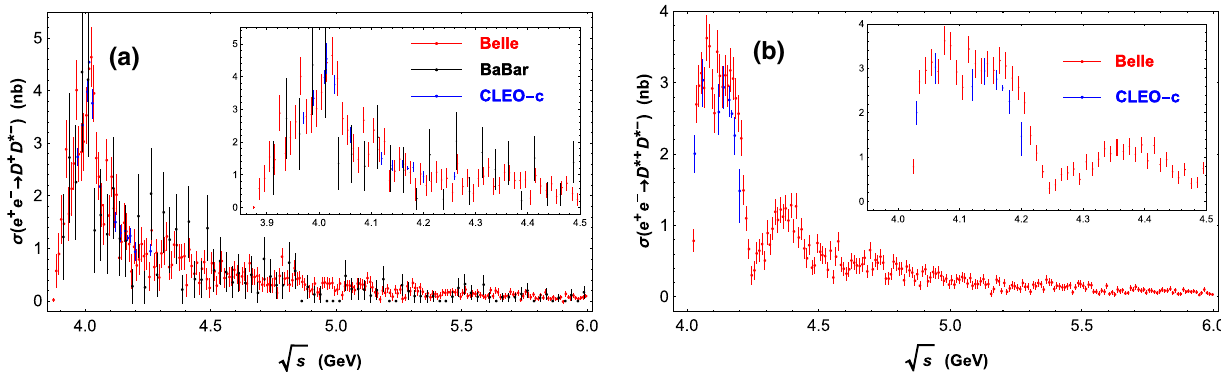
√ s (in the unit of GeV) for e + e − → D + D ∗− in ( a ) and e + e − → D ∗+ D ∗−